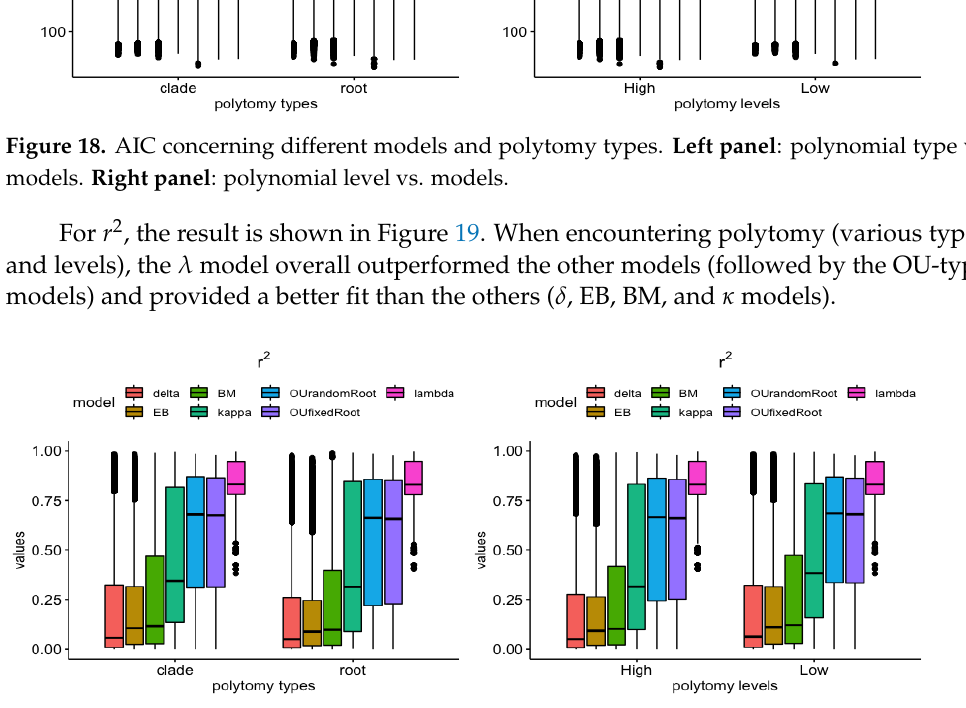
Figure 19. r 2 concerning different models and polytomy types. Left panel : polynomial type vs. models. Right panel : polynomial level vs. models.